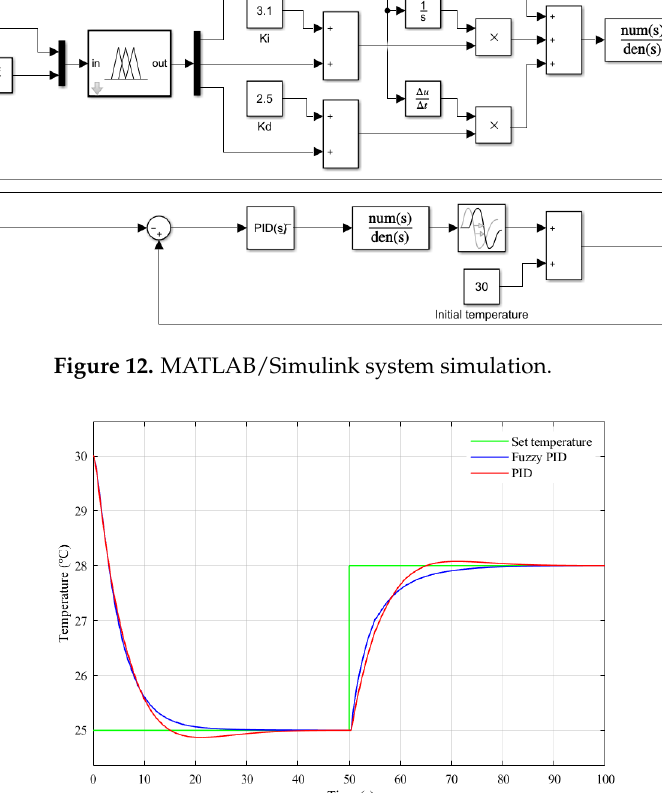
Figure 14. Semiconductor laser current drive and temperature control experimental system: (1) DC regulated power supply, (2) constant-current driver circuit, (3) butterfly semiconductor laser, (4) temperature control circuit, (5) microcontroller, and (6) PC. 5.1. Experiments with Constant-Current Output Characteristics The driving current test range was set from 0 to 100 mA, and the driving current was set at 2 mA intervals to obtain the relationship between the actual and set values of the driving current. Based on the experimental data, the actual value of the drive current, 𝐼 𝐿𝐷 ,